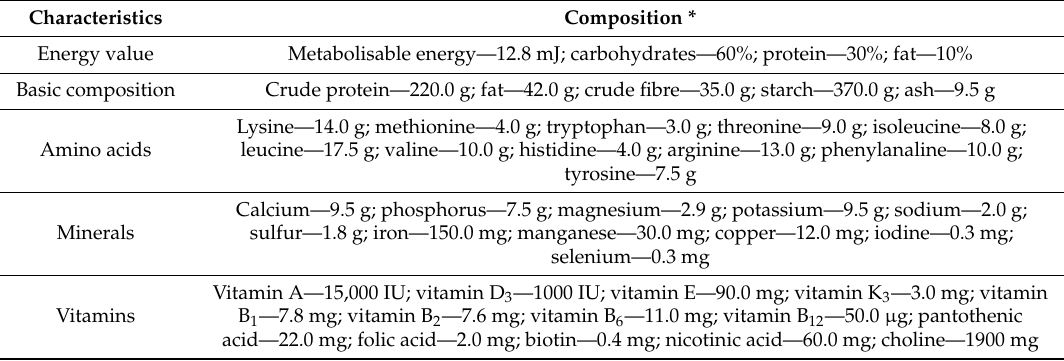
Table 1. The composition of the applied standard laboratory